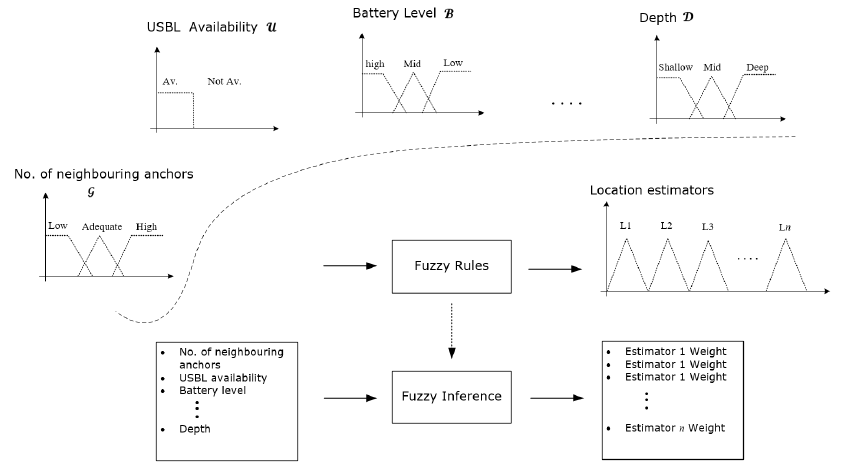
Figure 6. Fuzzy-based